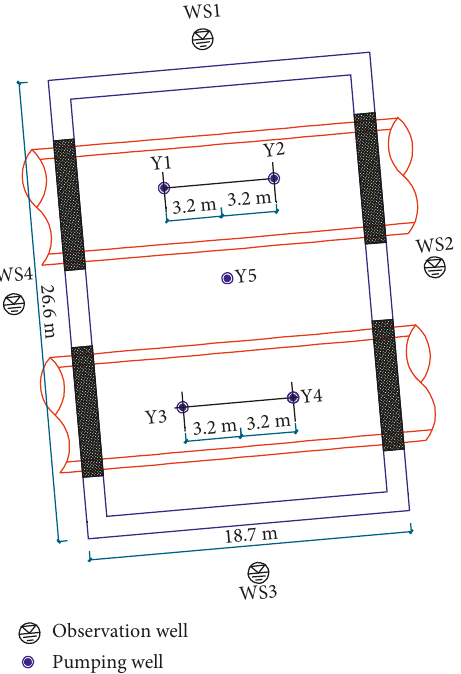
Figure 2: The layout of the pumping test and monitoring points.